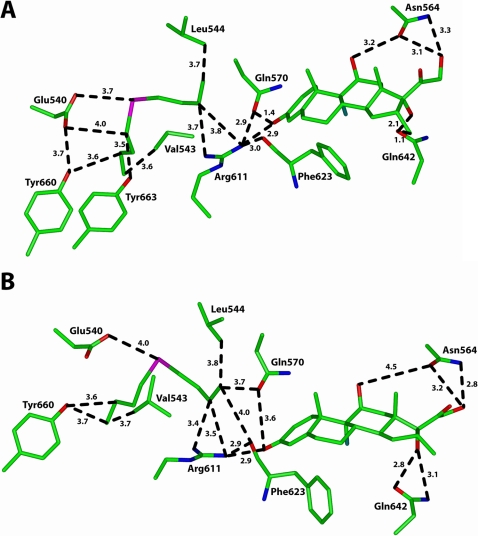
Interactions of dibutyltin with the GR in an allosteric site close to the dexamethasone-binding site.
A, After minimization of the 3D-model of the DBT-GR complex, dexamethasone was inserted into the complex. There are steric clashes between dexamethasone and Gln570 and Gln642, which are absent in the GR crystal structure [21] (Fig. 7A). The distances of Asn564, Arg611 and Phe623 to dexamethasone are similar to that in the GR crystal structure. B, Interaction of dexamethasone with the GR after energy minimization of the DBT-GR-dexamethasone complex in (A) with Discover 3. Gln570 and Gln642 have moved and no longer have steric clashes with dexamethasone. Asn564, however, has moved to 4.5 Å from the C11 hydroxyl on dexamethasone.